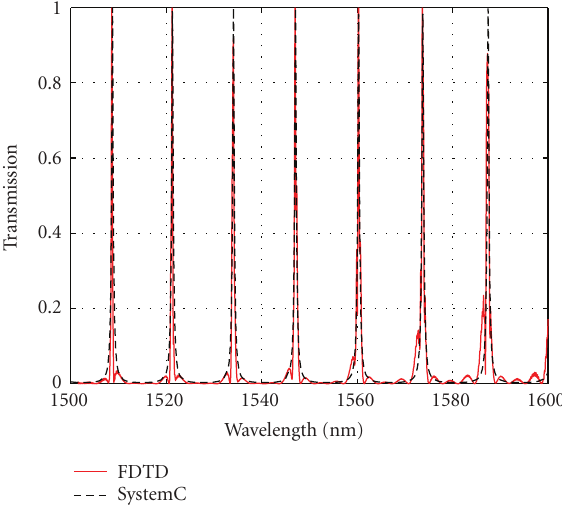
Figure 7: Simulated (solid line) and modeled (dashed line) transmission curves for the path linking the I-WEST port with the O-SOUTH port of the 4 × 4 optical